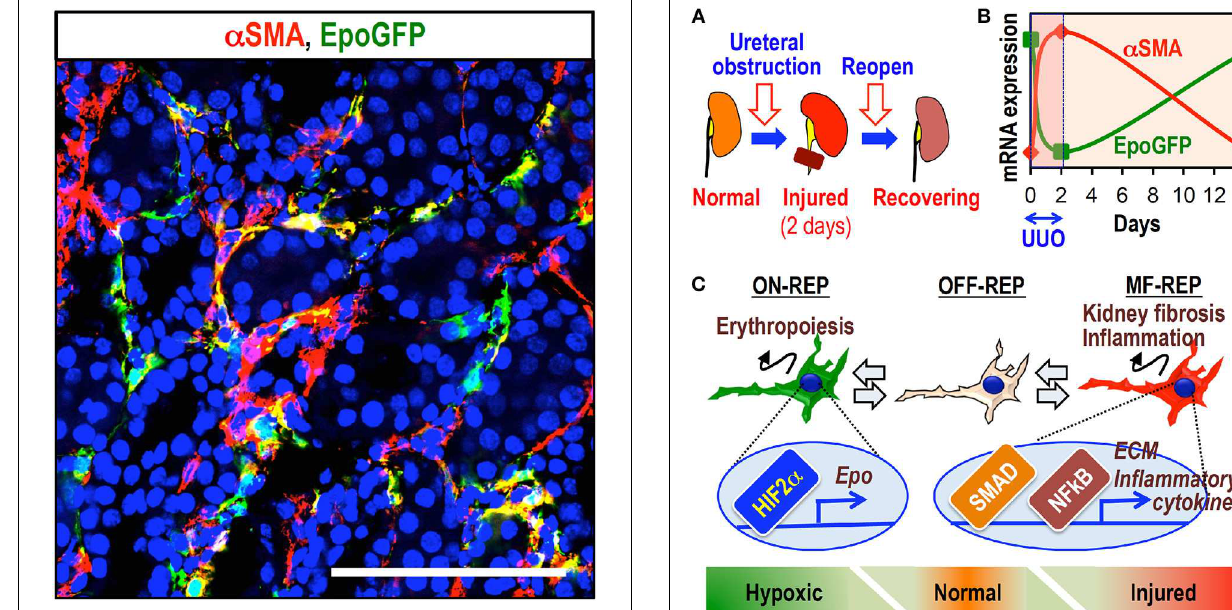
FIGURE 5 | The cellular plasticity of REPs governs both fibrosis and anemia. (A) Schematic diagram of the reversible UUO model. The left ureter is obstructed by a vascular clip for 2 days and then re-opened afterwards. (B) The inverse relationship between EpoGFP and α SMA mRNA expression in whole kidneys of ISAM during reversible UUO treatment. (C) Schematic summary showing the plasticity of REPs. MF-REPs produce extracellular matrix (ECM) and inflammatory cytokines in injured kidneys through SMAD and NF κ B signaling cascades. After the resolution of environmental cues, MF-REPs revert to their original and physiological Epo-producing phenotype. Switching between ON-REPs and OFF-REPs is determined in a hypoxia-dependent manner via HIF2 α